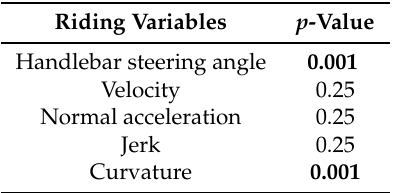
Table 5. p -value of the AD test between clusters 2 and